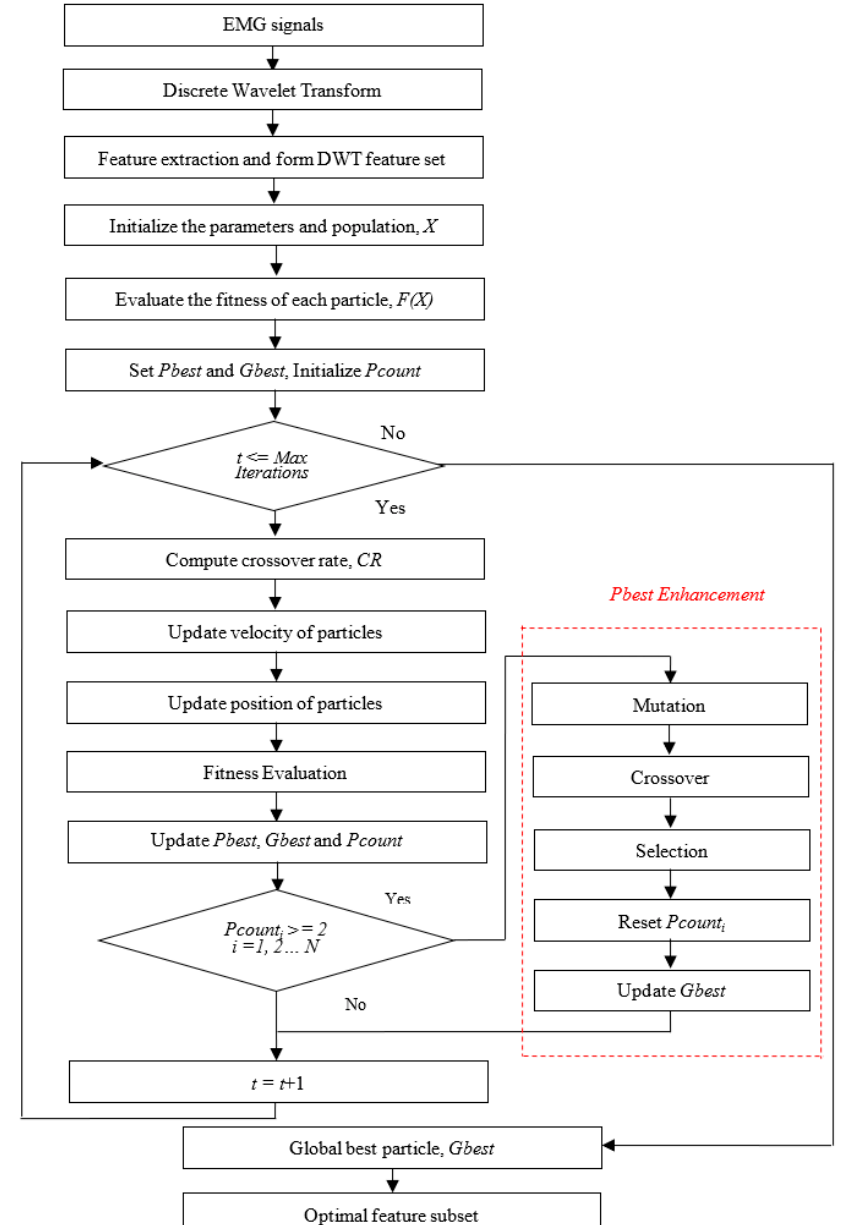
Figure 4. Flowchart of proposed PBPSO for feature selection.